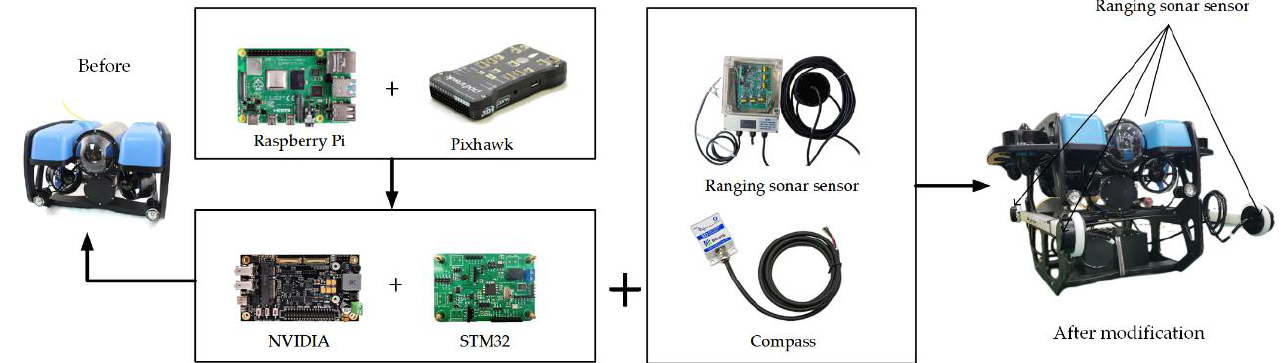
Figure 6. Schematic diagram of improved BlueROV hardware framework.